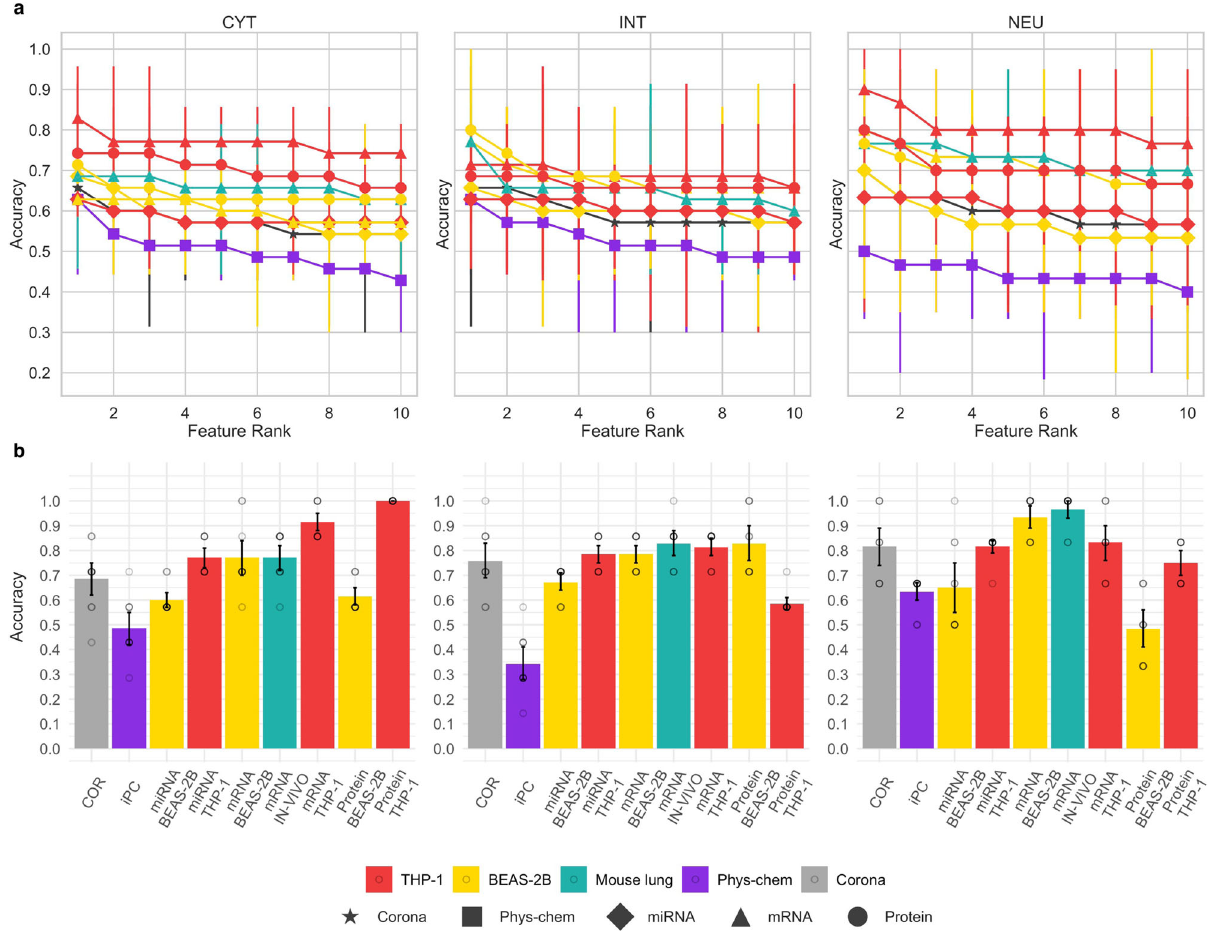
Fig. 3 Comparison of selected models from different data layers and cell types. a Classi fi cation performances obtained from univariate-based models. Each panel reports the test set accuracy estimates ( n = 5-fold cross-validation strategy). Data were represented as mean values and 95% con fi dence intervals. On the X-axis of each plot, the ten single top-performing features of each corresponding dataset grouped with respect to the toxicity labeling used are represented. b Classi fi cation performances obtained from multivariate-based models. Each panel reports the mean values of the test set accuracy estimates together with 95% con fi dence intervals ( n = 10 best models). Colors indicate the cell model (THP-1 is represented in red, BEAS-2B is represented in yellow, and mouse lung is represented in turquoise), protein corona (represented in gray) and intrinsic properties (represented in violet and named as phys-chem), while the x-axis labels indicate the speci fi c name of the employed data layer. The labels on the top indicate the classi fi cation tasks. (CYT) The testing accuracy of models selected for the cytotoxicity score, (INT) the integrated toxicity score, and (NEU) the in vivo toxicity-based classi fi cation